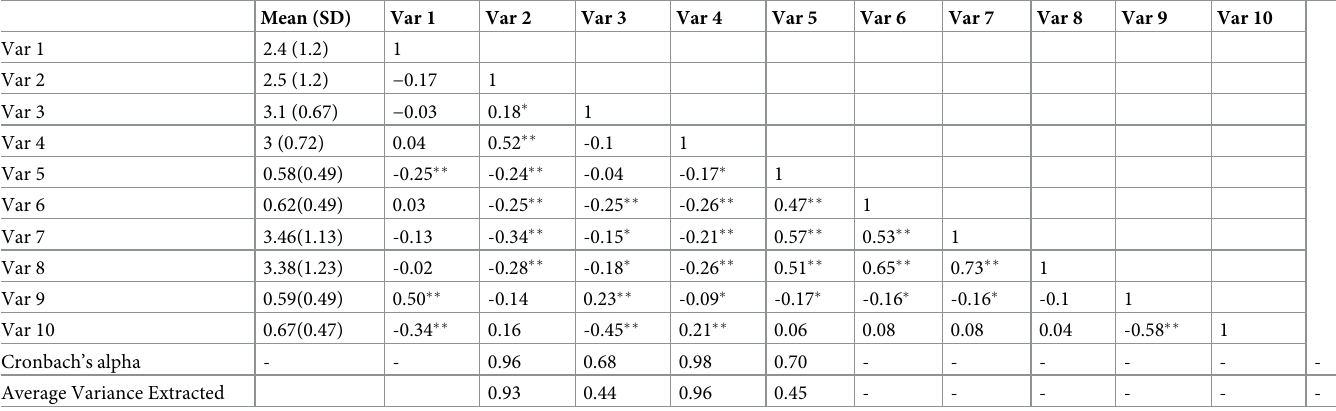
Table 2. Pearson correlation coefficients, mean (standard deviation), and Cronbach’s alpha among the study variables (N = 315